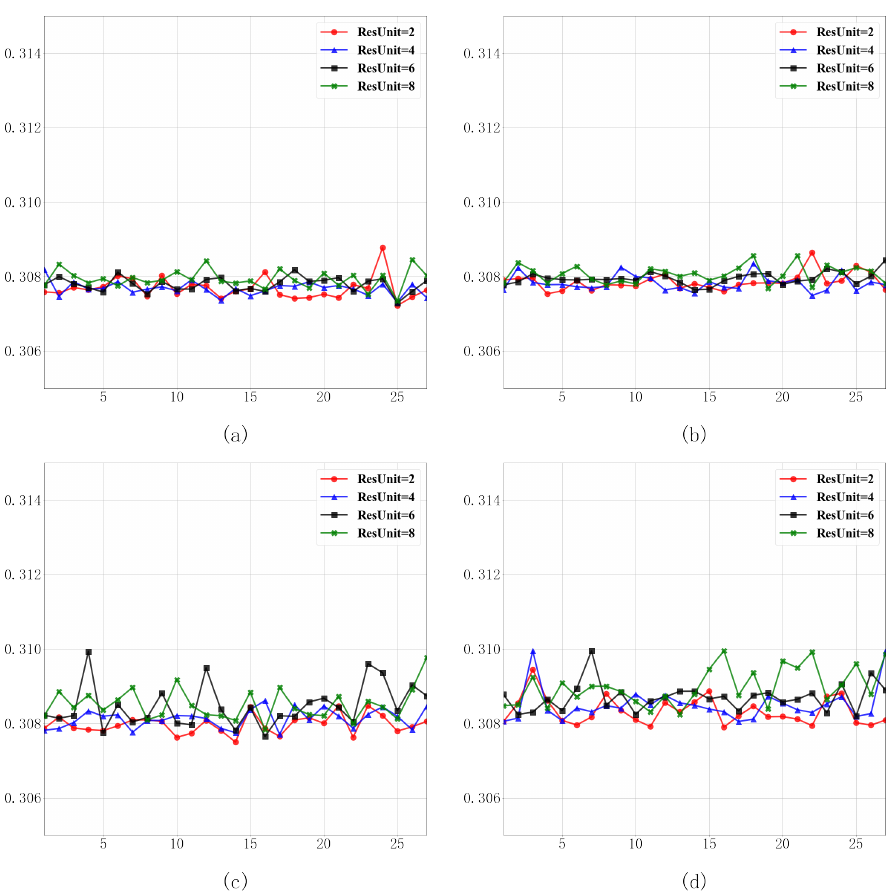
Figure 7. Parameter sensitivity study on the performance of ST3DNetCrime: ( a ) the number of filters in the convolution layers is 8; ( b ) the number of filters in the convolution layers is 16; ( c ) the number of filters in the convolution layers is 32; ( d ) the number of filters in the convolution layers is 64. Units: x -axis: number of combinations of three independent sequence lengths; y -axis: RMSE